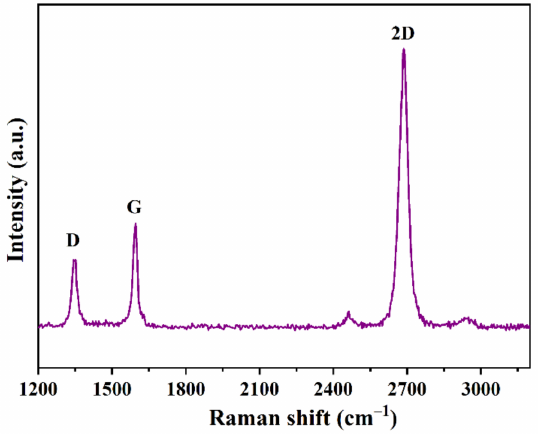
Figure 6. Raman spectrum of a graphene sample grown by a